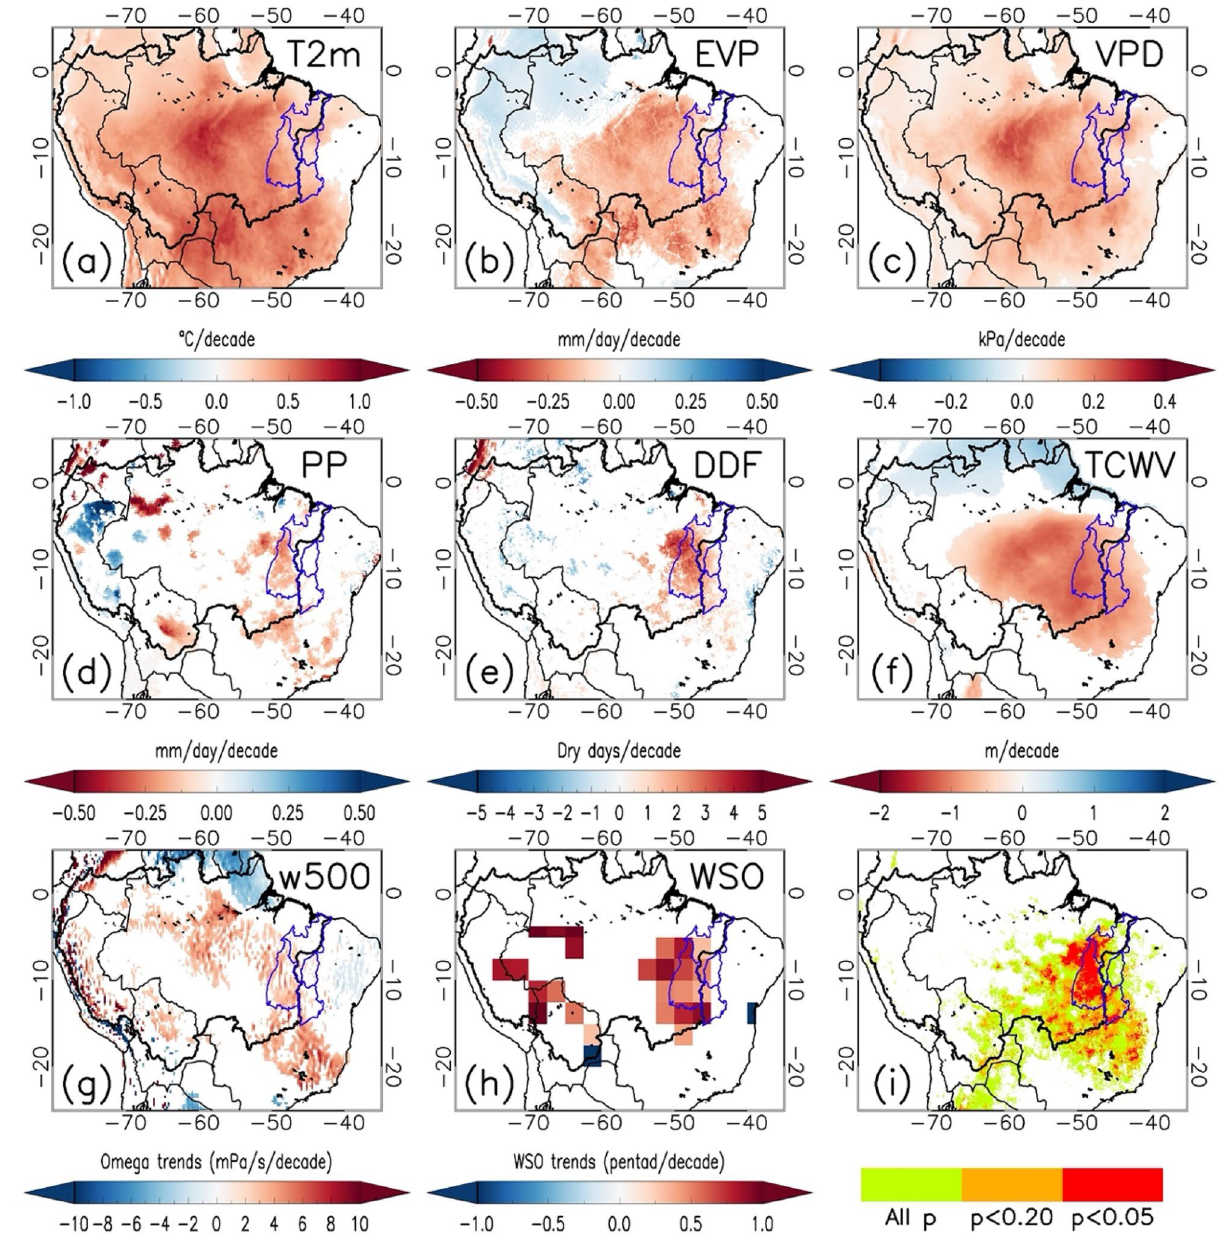
Figure 1. Spatial patterns of trends and compound changes. Trends (1981–2020) for the JASO seasonal period in air temperature T2m ( a ), actual total evapotranspiration EVP ( b ), vapor pressure deficit VPD ( c ), precipitation PP ( d ), frequency of dry days DDF ( e ), atmospheric water vapor content TCWV ( f ), omega at 500 hPa ( g ) and wet season onset WSO (h) . Values of trends given in units per decade. Only pixels statistically significant at the α = 0.05 level are displayed. Hydrological and climate changes are combined to display those pixels where positive trends in T2m, VPD and DDF, and negative trends in PP, EVP and TCWV are simultaneously observed ( i ). Compound trends are categorized into three levels: pixels without statistical significance (All p), pixels statistically significant at p < 0.2, and pixels statistically significant at p < 0.05. In all maps, the Amazon and MATOPIBA regions are marked by black and blue contour lines, respectively. Data visualisations produced using IDL v8 (Harris Geospatial Solutions, season, including deciduousness, leaf anatomical and morphological characteristics, canopy structure, and soil hydraulic mechanisms 59 . All these processes are fundamentally linked to canopy–atmosphere coupling, with complex interactions between climate, plant phenology and soil hydraulic mechanisms. The analysis of long-term trends (Fig. 1a–h) evidenced that some of the hydrological and climate changes are already widespread in EAC, whereas other changes are focused on southern/southeastern Amazonia or even